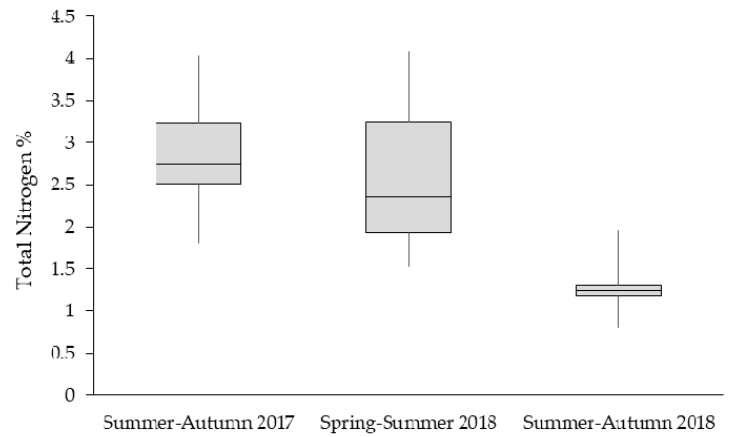
Figure 2. Percent Nt values of field samples measured in the laboratory. The minimum, maximum (vertical bars), and median (solid lines) are displayed.